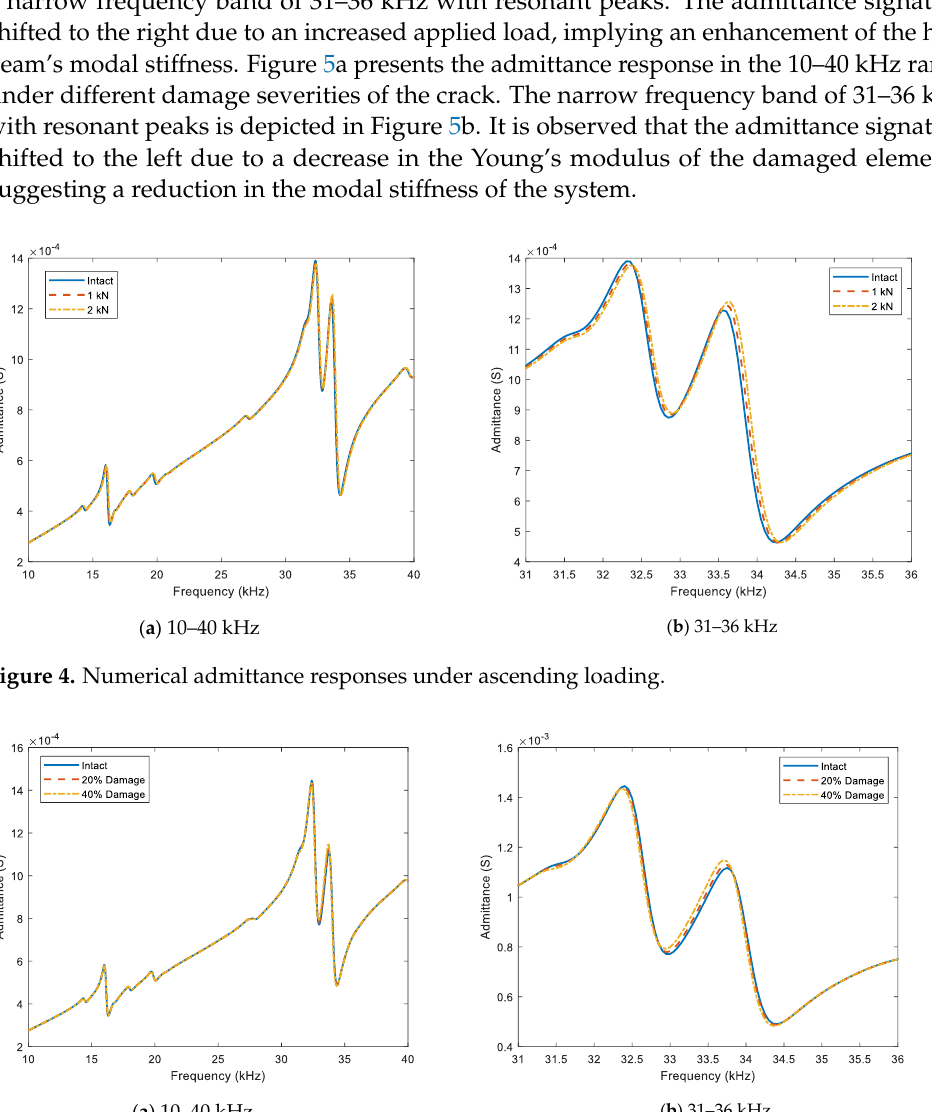
Figure 5. Numerical admittance responses under reduced stiffness of damaged beam element.